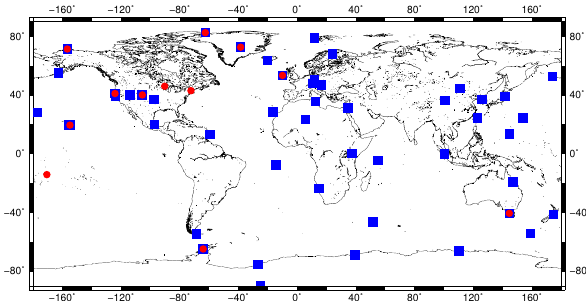
Fig. 1. Surface sites from the NOAA, ENEA, CSIRO, JMA and Fig.1. SurfacesitesfromtheNOAA,ENEA,CSIRO,JMAandNIWAnetworksusedinthisstudywithred NIWA networks used in this study with red circles for surface sites circlesforsurfacesitesobservingMCFdryairmolefractionsandbluesquaresforsurfacesitesobserving CH 4 observing MCF dry air mole fractions and blue squares for surface dryairmolefractions. sites observing CH 4 dry air mole